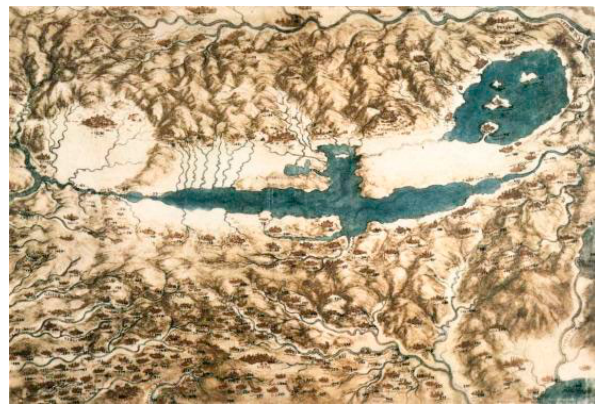
Figure 3. Map of Valdichiana , Windsor, Royal Library,